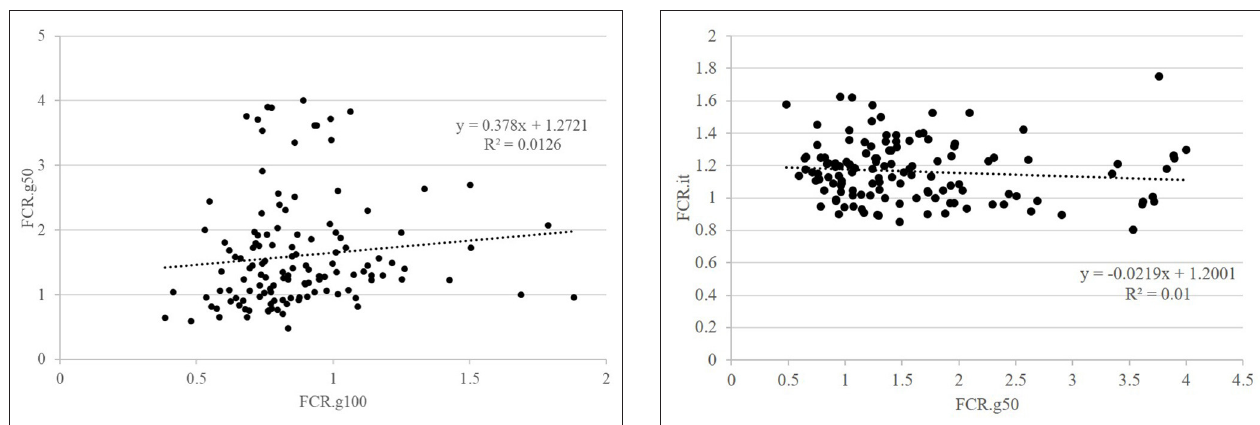
FIGURE 3 | Relations between FCR when fish were fed a restricted feed and reared in groups (g50) or in isolation (it). Data for GIFT only. Each point is representing data for one